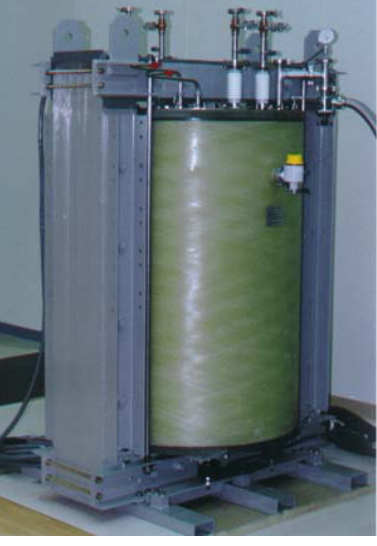
Figure 6. “Fuji/SEC/Kyushu University HTS transformer unit”. Source: HTS transformer